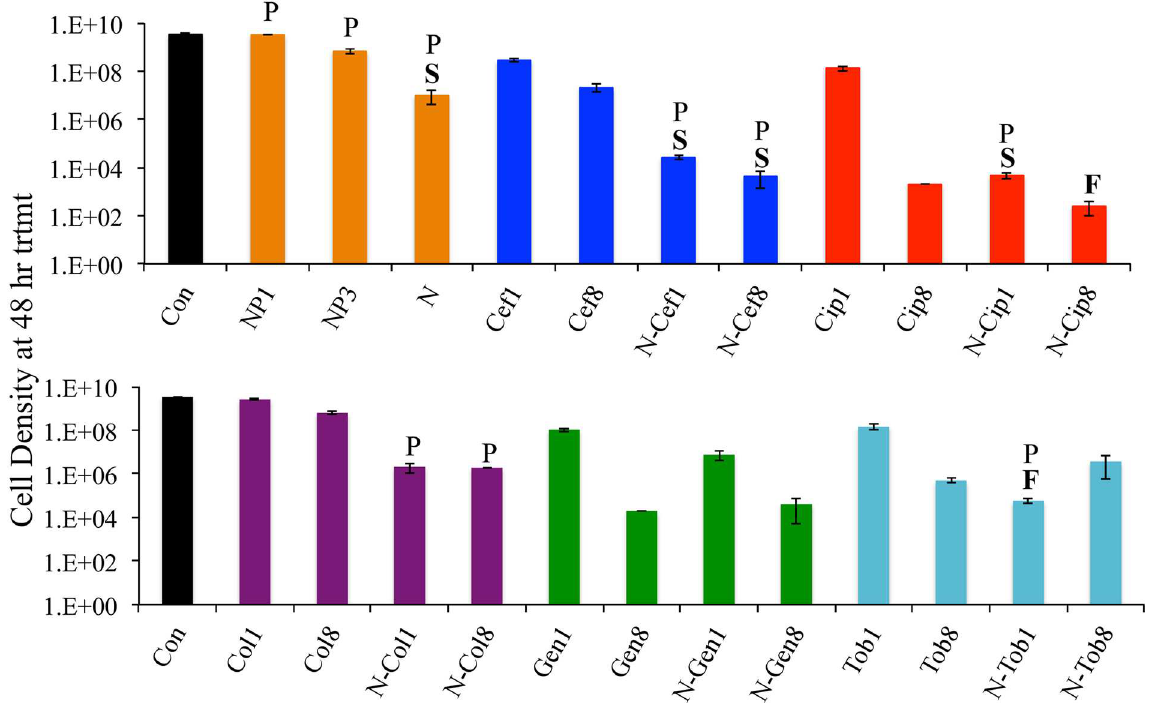
Fig 3. Treatment of intact biofilms grown on plastic. Viablecell densities(mean ± standarderror, three replicates) in 48 hours, intact biofilm populations of P . aeruginosa PA14 on plastic then treated for 48 hours in variouscombinations of two phages(NP1, NP3) and/or five antibiotics (ceftazidime, ciprofloxacin, colistin, gentamicin, and tobramycin). Antibiotics were used at 1X and 8X MIC concentrations. Abbreviations are given by the first 3 letters of the drug name, and the number followingthe abbreviationindicates1X or 8X MIC. A prefix N- indicatesinclusionof both phages.“Con” is the untreated control with no antibiotic or phage addedas treatment. A ‘P’ abovethe bar indicates that the phage titer at 48 hours exceededthe inoculumdensity by at least a factor of 10. ‘S’ indicatesstatistical support for synergy, ‘F’ for facilitation. Raw data of these experiments can be found in (S1 Excel File).